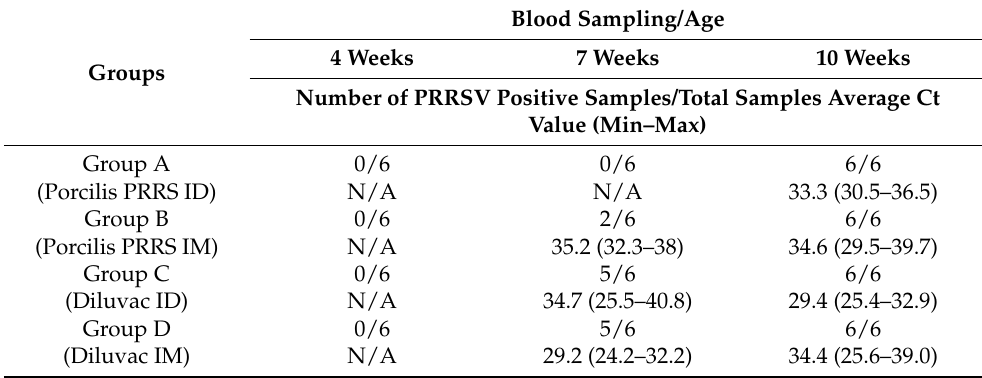
Table 1. Results of qRT-PCR in blood serum samples of the sampled animals at ages of 4, 7 and 10